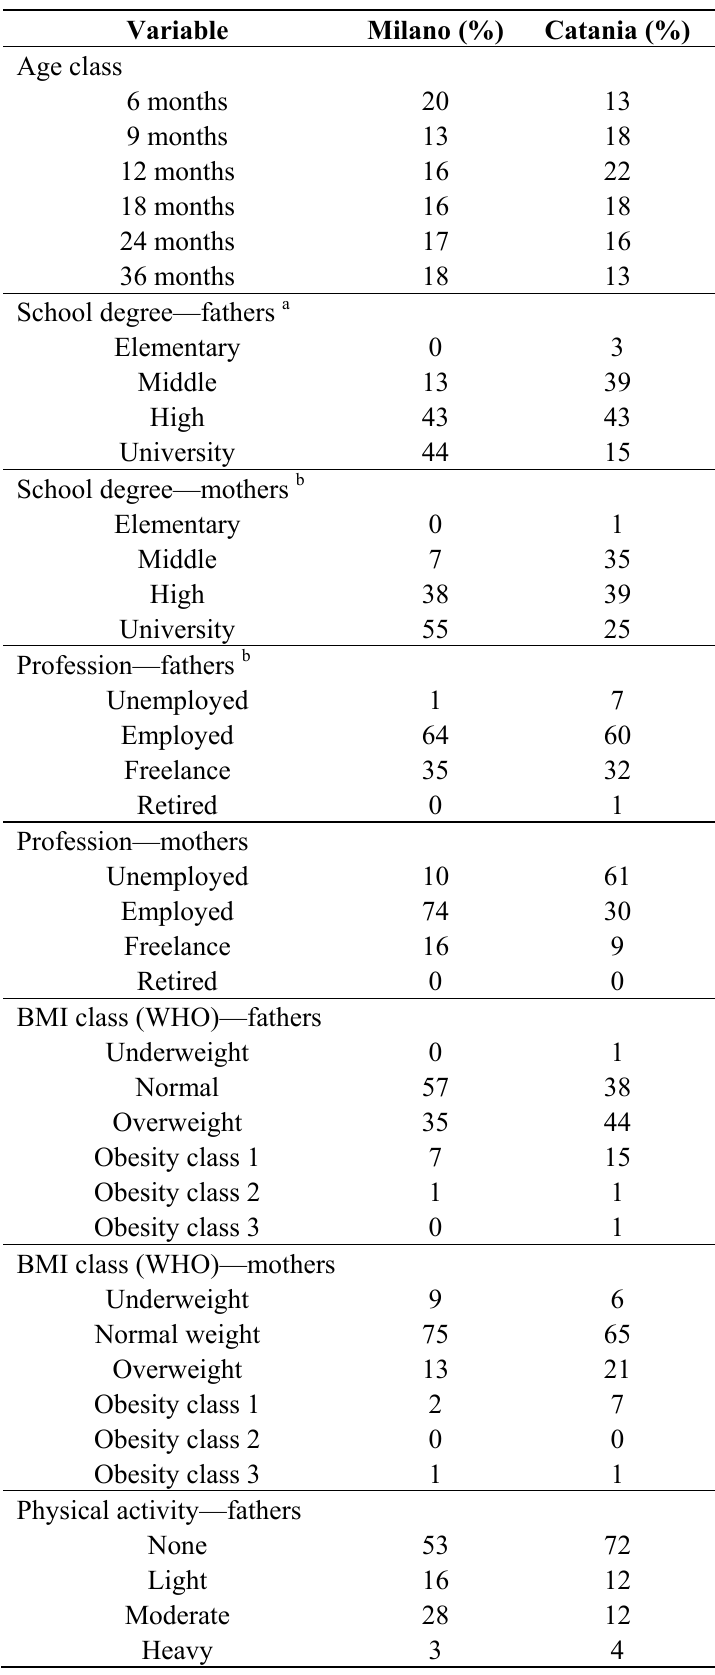
Table 1. Within-place distribution of age and family characteristics of NI636